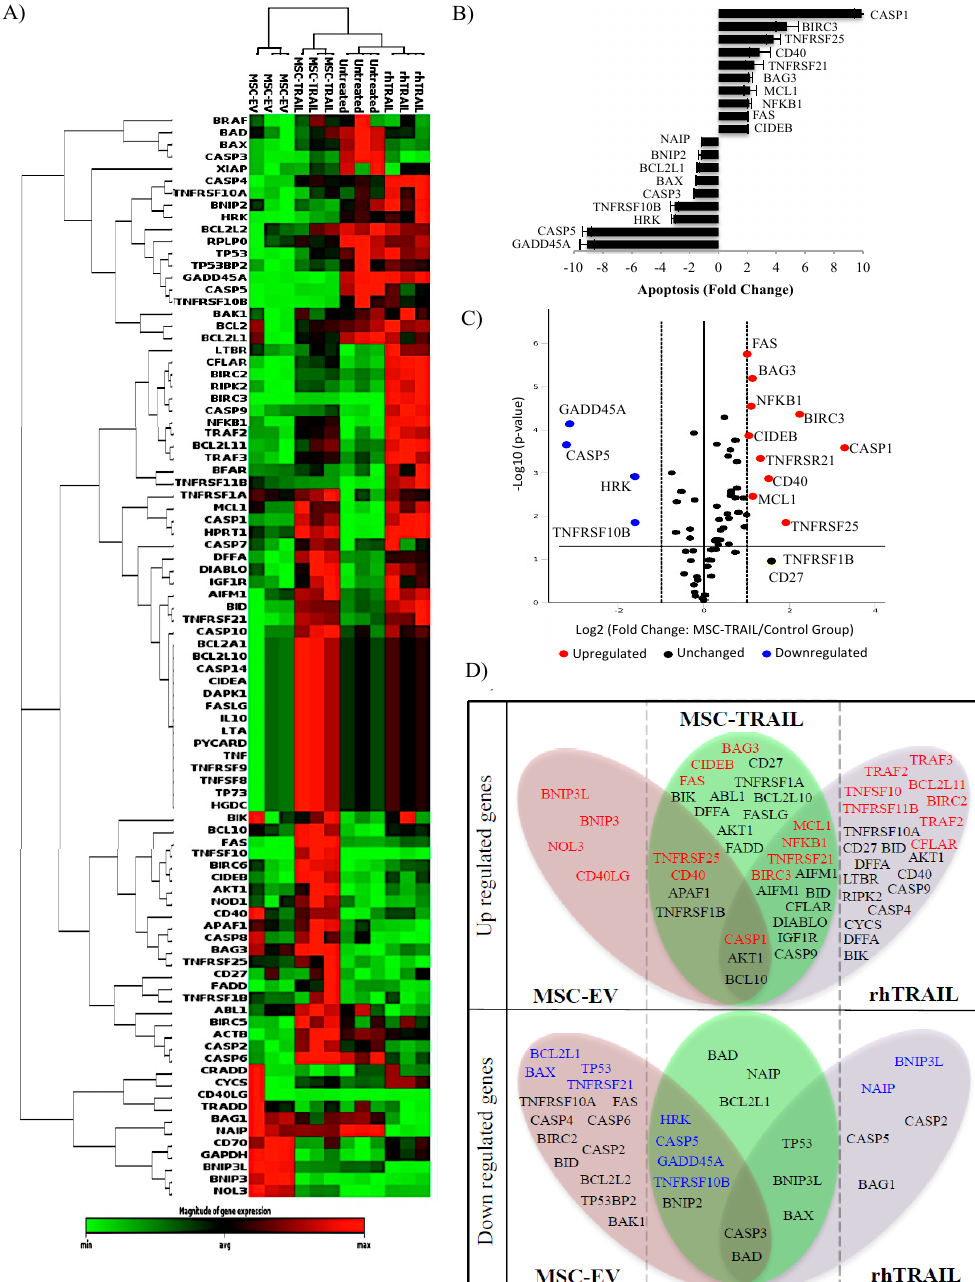
Figure 8. Analysis of apoptotic genes in CD133 + H460-derived CSCs regulated by MSC-TRAIL. ( A ) Hierarchical cluster of CSCs treated with MSC-TRAIL, MSV-EV, rhTRAIL, and untreated control ( n = 3). ( B ) Bar chart and ( C ) volcano plot showing fold-change (FC) of regulated genes (blue dots / downregulated, FC ≤ 2 and red dots / upregulated, FC ≥ 2.0) with p ≤ 0.05 from CD133 + H460-derived CSCs treated with MSC-TRAIL. ( D ) Venn diagram depicting significantly regulated genes ( p ≤ 0.05) clustered into the three treatment groups (MSC-TRAIL, rhTRAIL, and MSC-EV). The highlighted genes (red and blue) indicate FCs of ≥ 2 and ≤ 2, respectively.